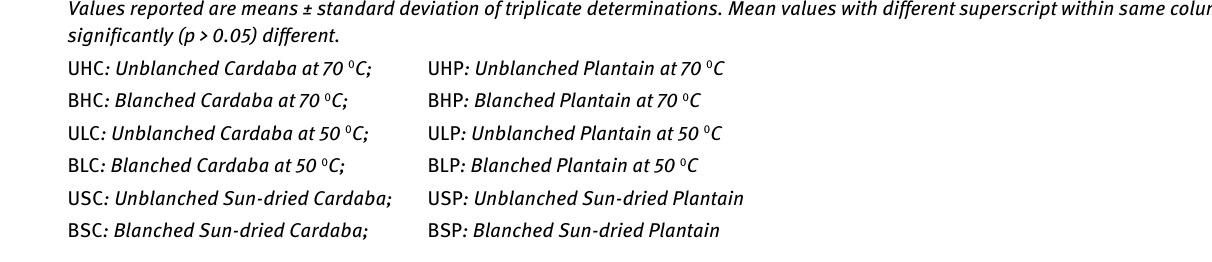
Values reported are means ± standard deviation of triplicate determinations. Mean values with different superscript within same column are significantly (p > 0.05) different.